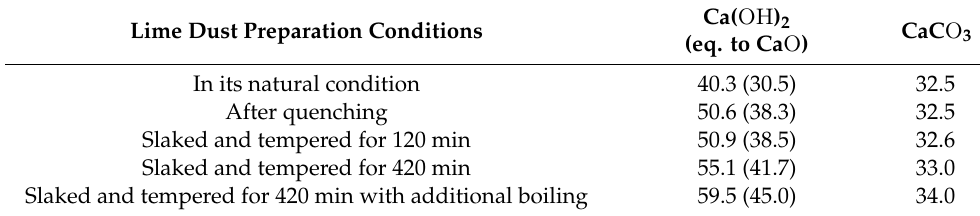
Table 1. Changes in the content of the main phases in lime dust under various conditions of its preliminary preparation (%